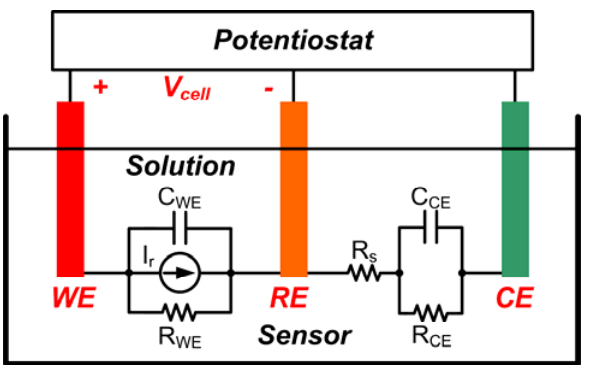
Figure 9. The impedance model of sensor.